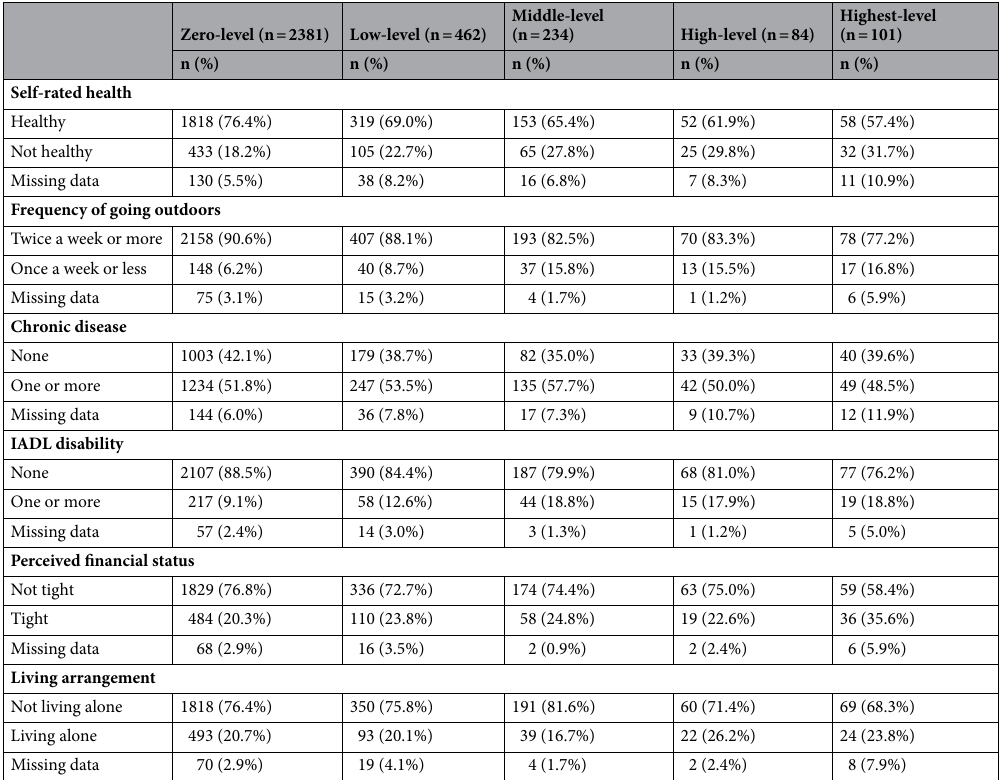
Table 1. Characteristics of participants at baseline survey by disengagement levels (N = 3262). IADL Instrumental Activities of Daily